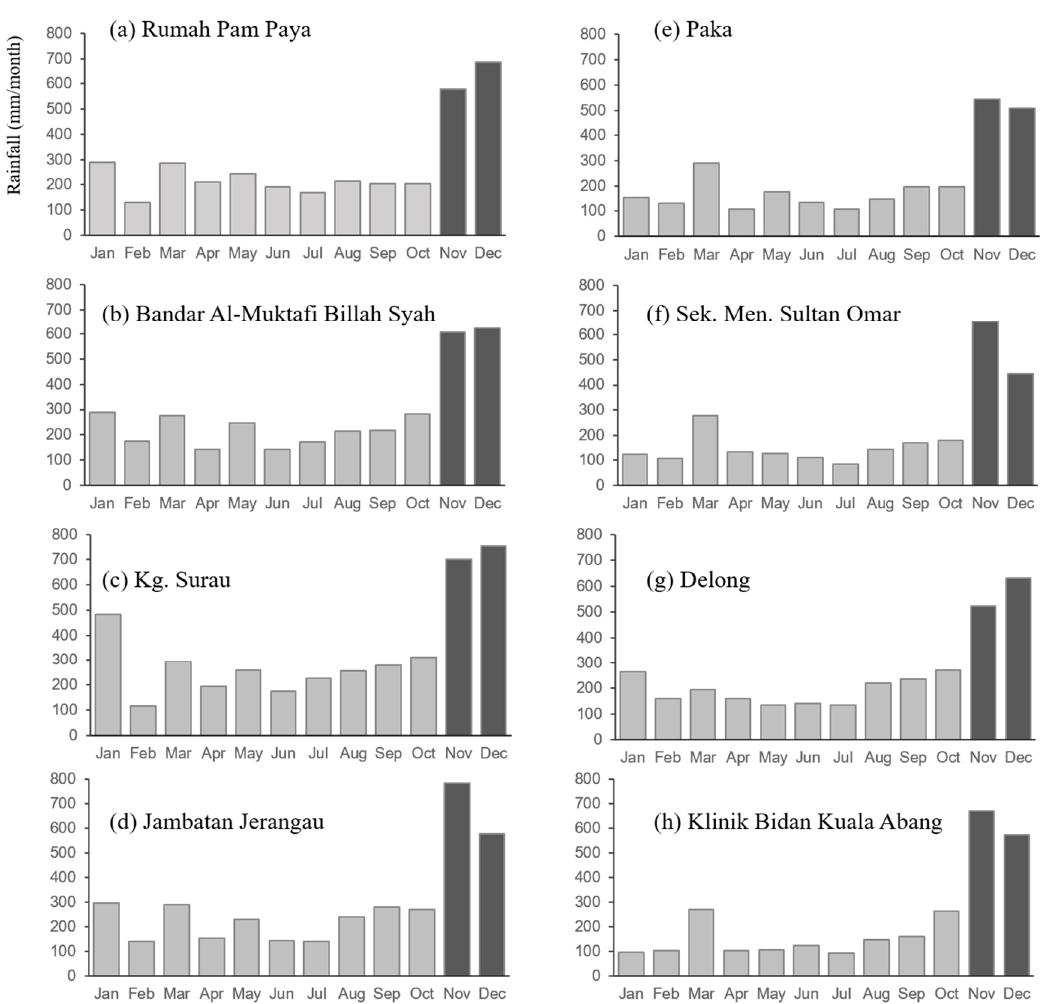
Figure 3. Hyetograph (1988–2016) for all the rain gauge stations of the study area.